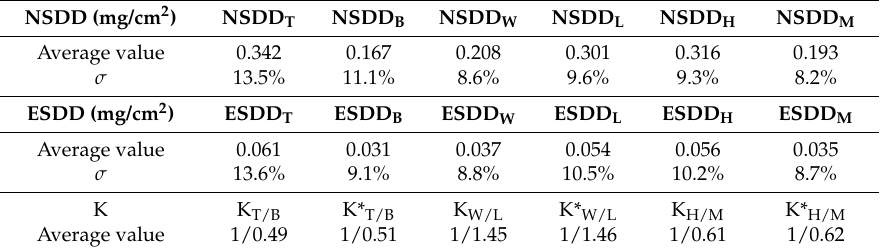
Table 1. Contamination degree and non-uniformity results for field operating insulators.